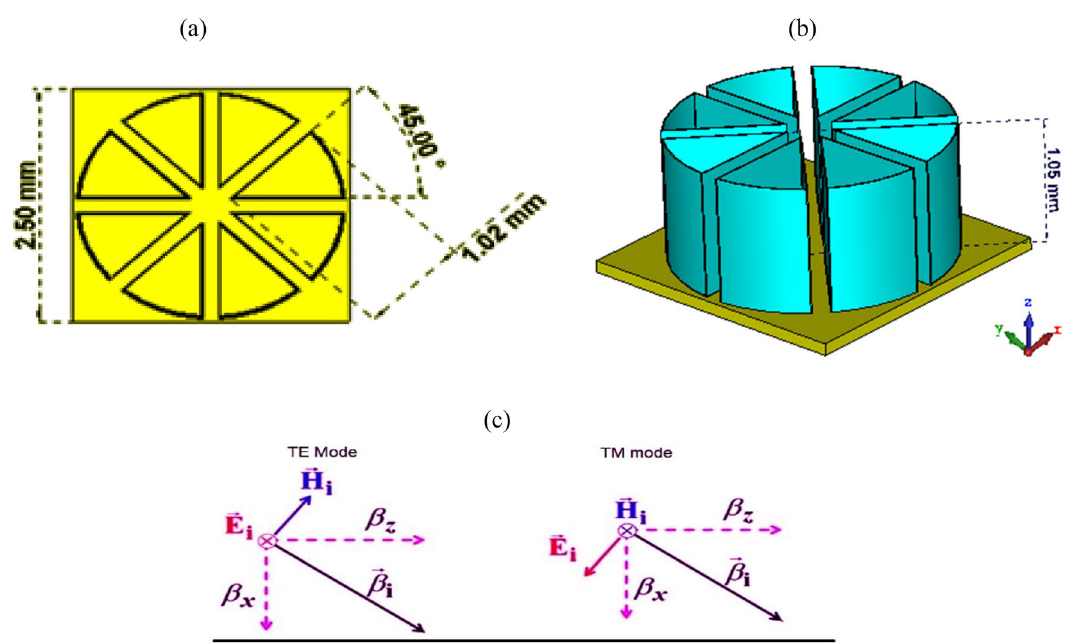
Figure 1. Absorber structure ( a ) top view and ( b ) 3-D view ( c ) schematic view of TE and TM